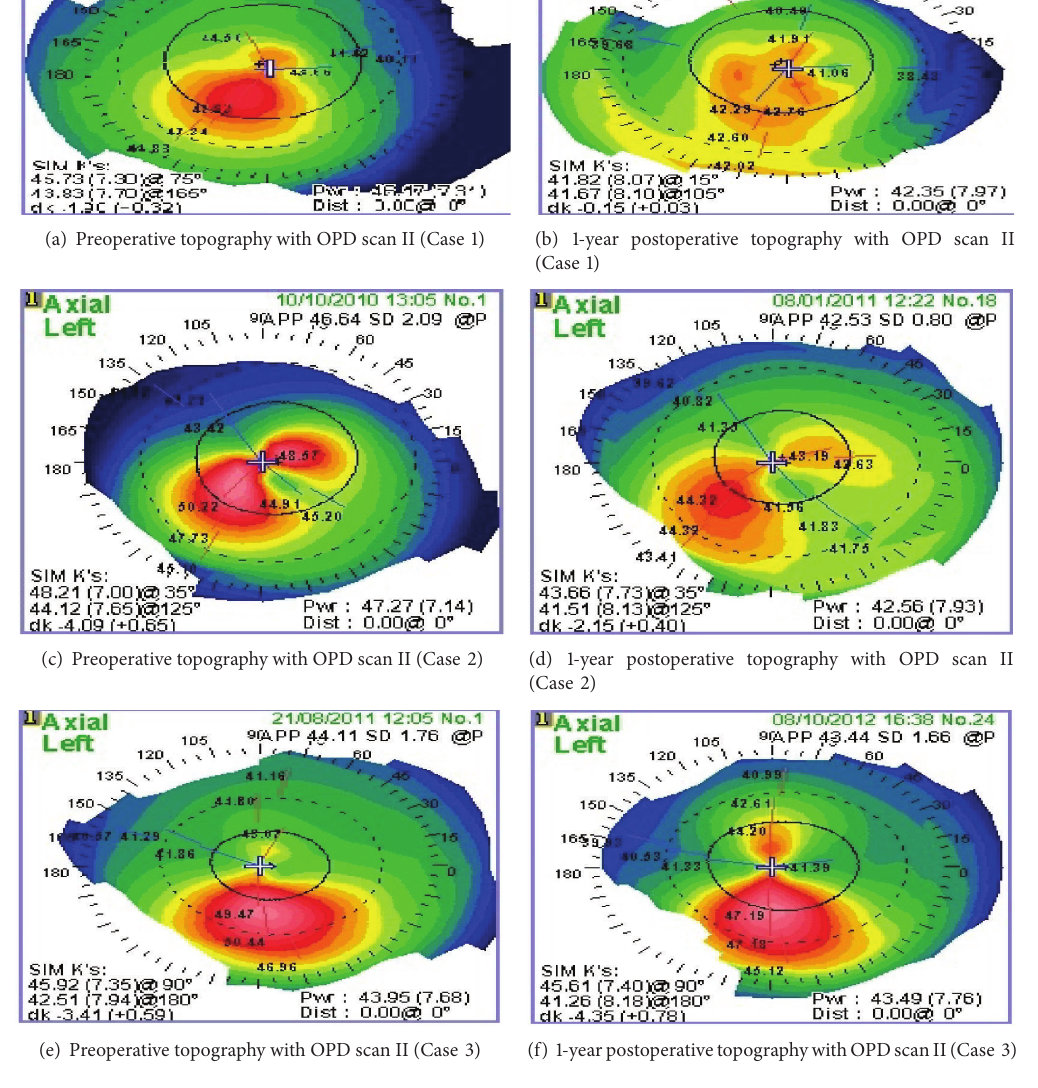
Figure 5: Comparative topography maps before and after surgery.